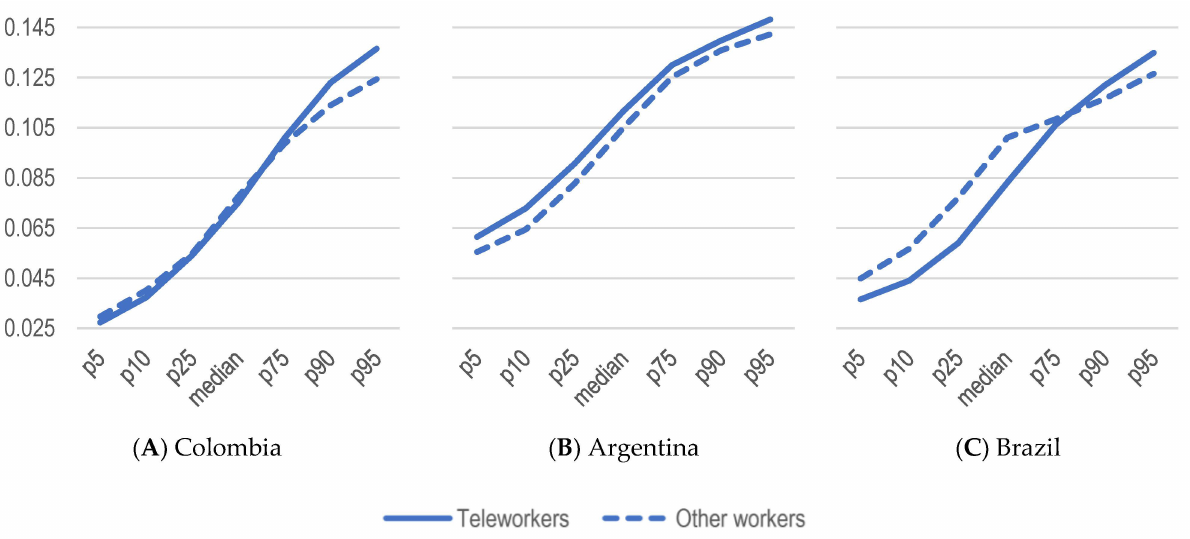
Figure 1. Main statistical moments of the distribution of the job quality indices estimation for Colombia, Argentina, and Brazil 2021. Source: Own elaboration based on GEIH-DANE, EPH- Argentina, and